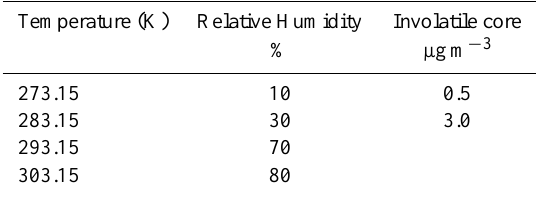
Table 1. Conditions for the partitioning calculations used with each scenario (all combinations used giving 32